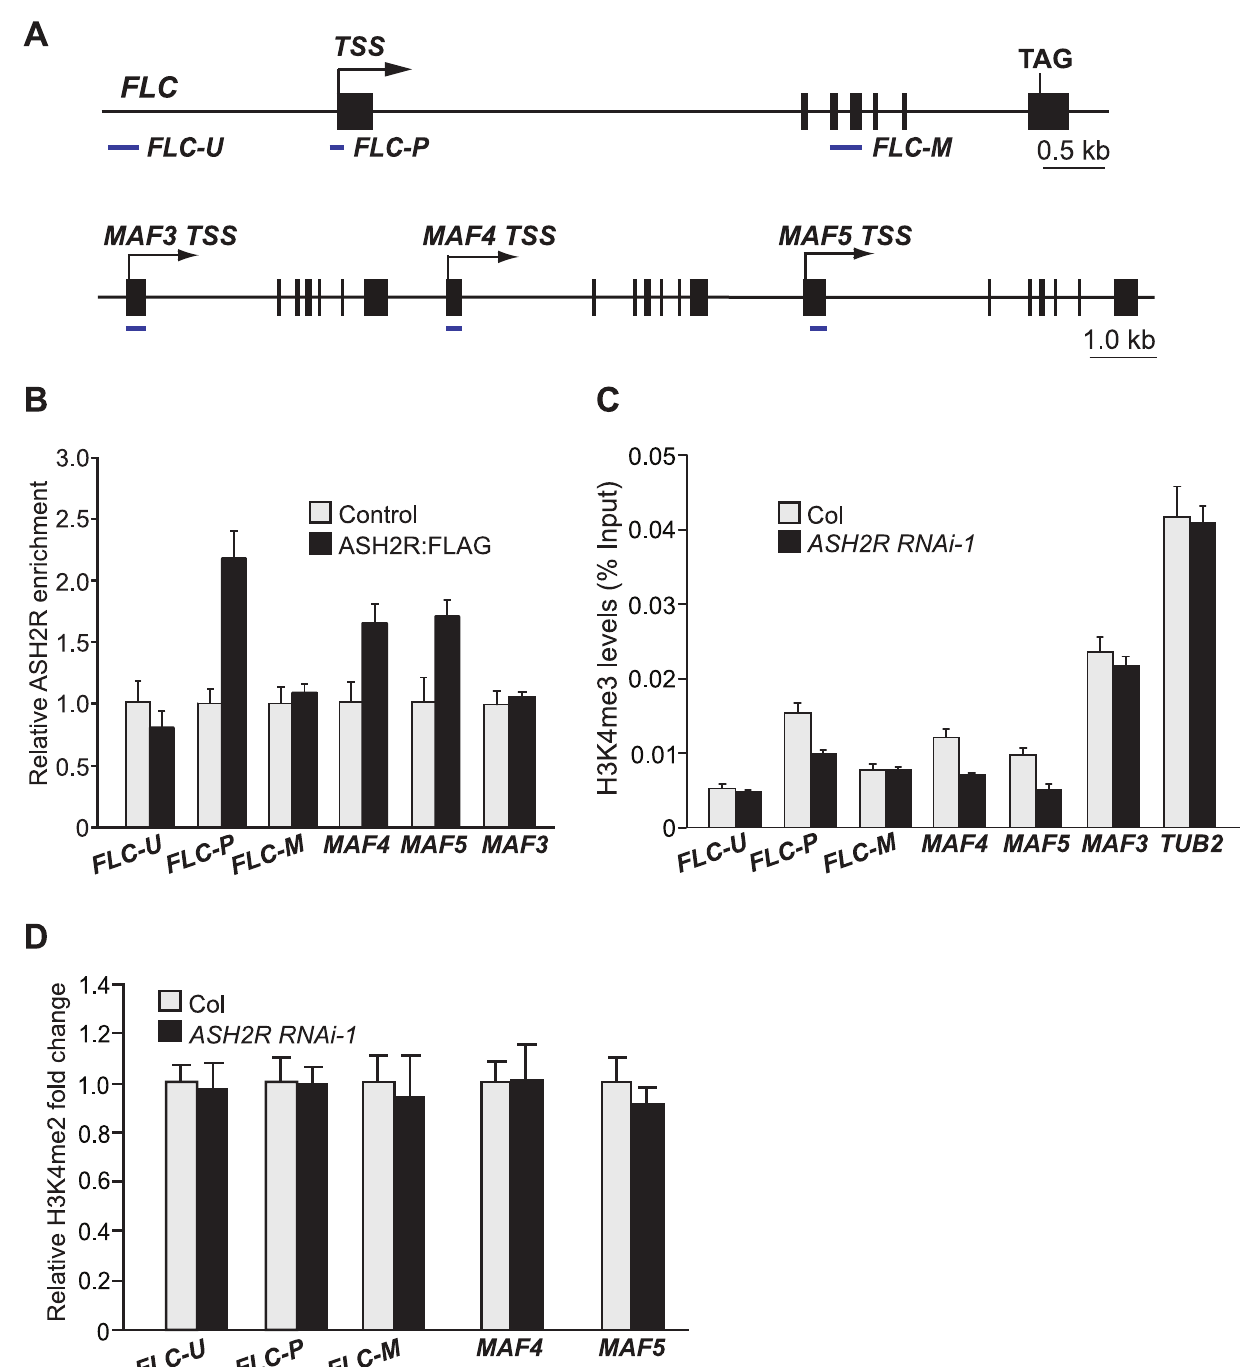
Figure 10. ASH2R Directly Mediates H3K4 Trimethylation in Its Target Genes FLC , MAF4 , and MAF5 . (A) Schematic structures of FLC , MAF3 , MAF4 and MAF5 . The regions examined in ChIP experiments are indicated with solid lines under each region. The transcription start site (TSS) for each gene is indicated by an arrow, and filled boxes for exons. (B) ASH2R enrichment at the FLC , MAF4 and MAF5 loci. Anti-FLAG was used to immunoprecipitate target chromatin extracted from wildtype-like seedlings of ASH2R:FLAG-1a (T 3 ) or Col (served as control). The amounts of immunoprecipitated genomic fragments were measured by real-time quantitative PCR, and subsequently normalized to TUBLIN2 ( TUB2 ), an internal control. The fold enrichments of the ASH2R:FLAG line over control (Col) at the indicated regions are shown. Error bars indicate SD. (C) H3K4me3 levels in FLC , MAF4 and MAF5 in Col and ASH2R RNAi-1 seedlings. The amounts of immunoprecipitated genomic fragments were quantified, and subsequently normalized to the input DNA. For each amplicon, the percentage of input is shown. Error bars indicate SD. (D) Analysis of H3K4me2 in FLC , MAF4 and MAF5 in Col and ASH2R RNAi-1 seedlings.